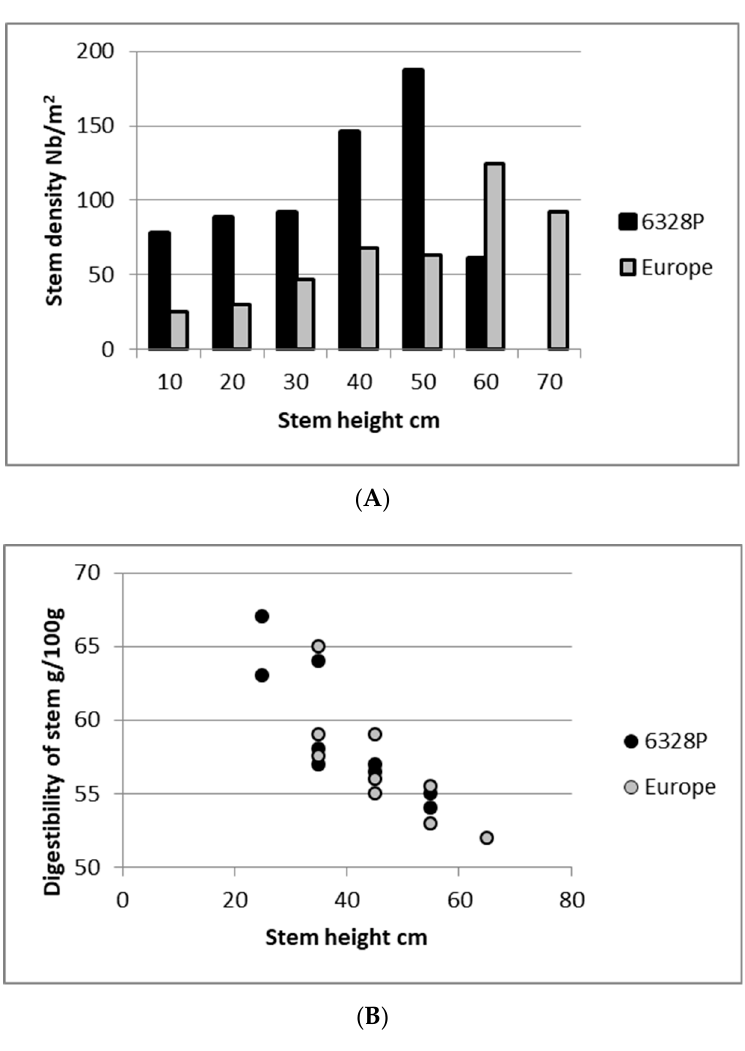
Figure 10. Distribution of stem height within an alfalfa stand for two cultivars ( A ) and the relationship between stem height and digestibility of stems ( B ). Data obtained at Lusignan (46.46 ◦ N; 0.07 ◦ E; France) and the graph was redrawn from Lemaire and Allirand [25].